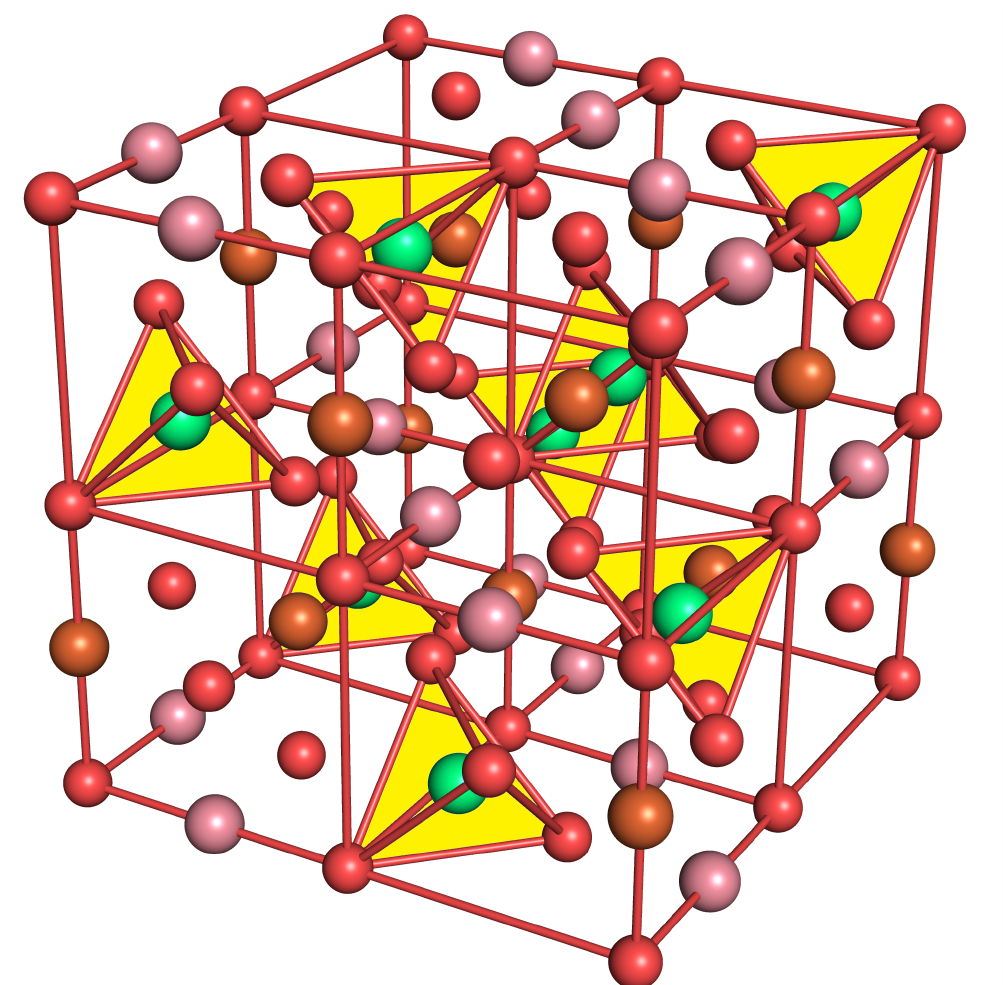
Figure 1. CoFe 2 O 4 bulk structure. Fe 3+ (tet) ions in tetrahedral voids (yellow) are shown in green, Fe 3+ (oct) and Co 2+ (oct) ions in octahedral voids in brown and purple and oxygen atoms in